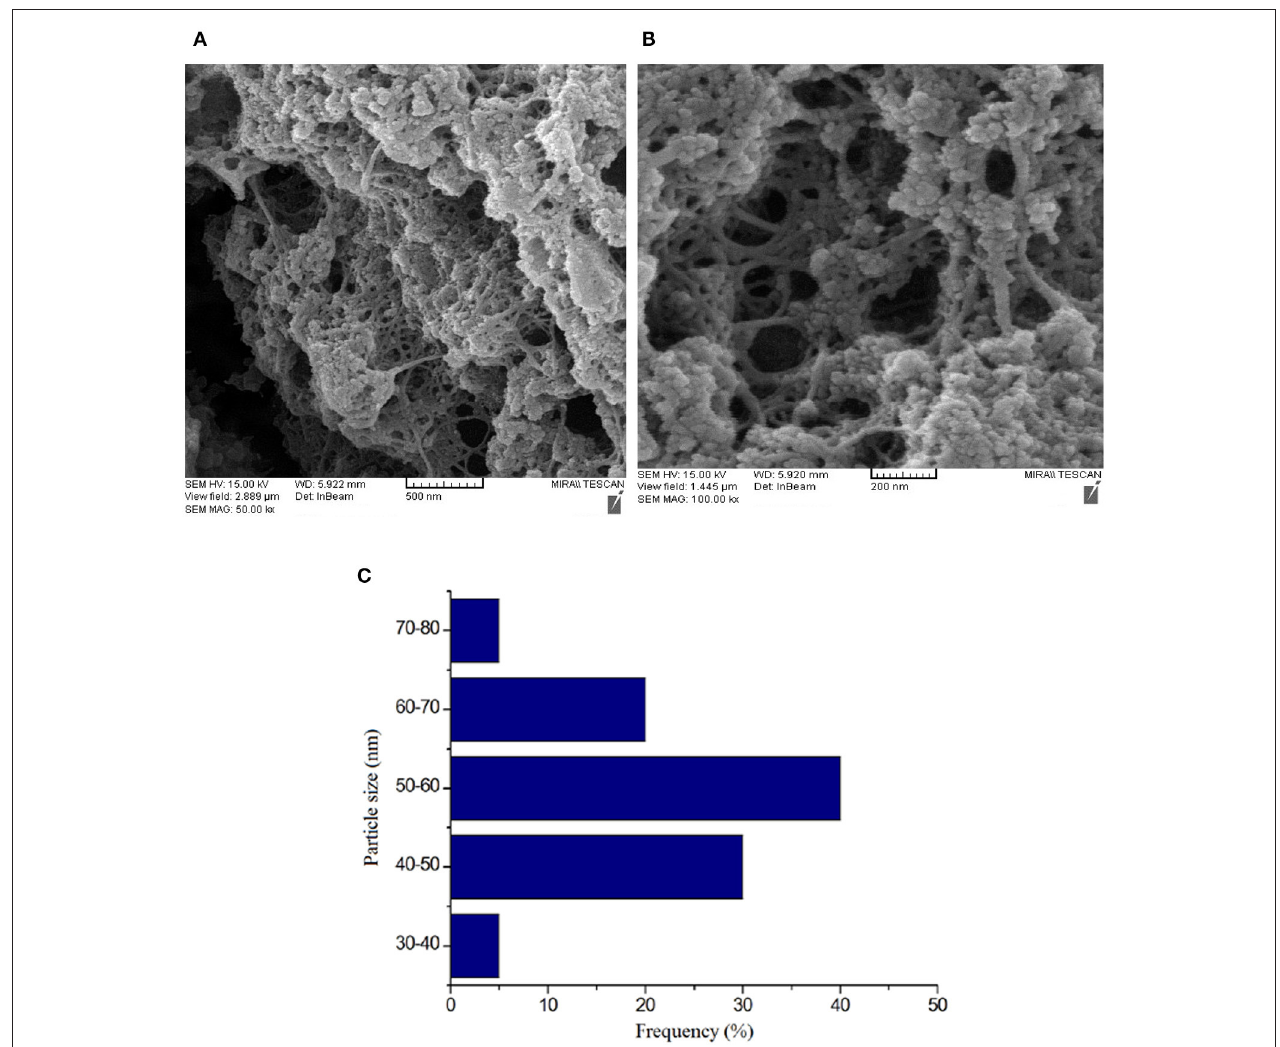
FIGURE 3 | Field emission scanning electron microscopy images of (A,B) the nano-ZnO/polyvinyl alcohol (PVA)/fluorinated tin oxide (FTO) at different magnifications and (C) its size distribution histogram. The particle size abundance was